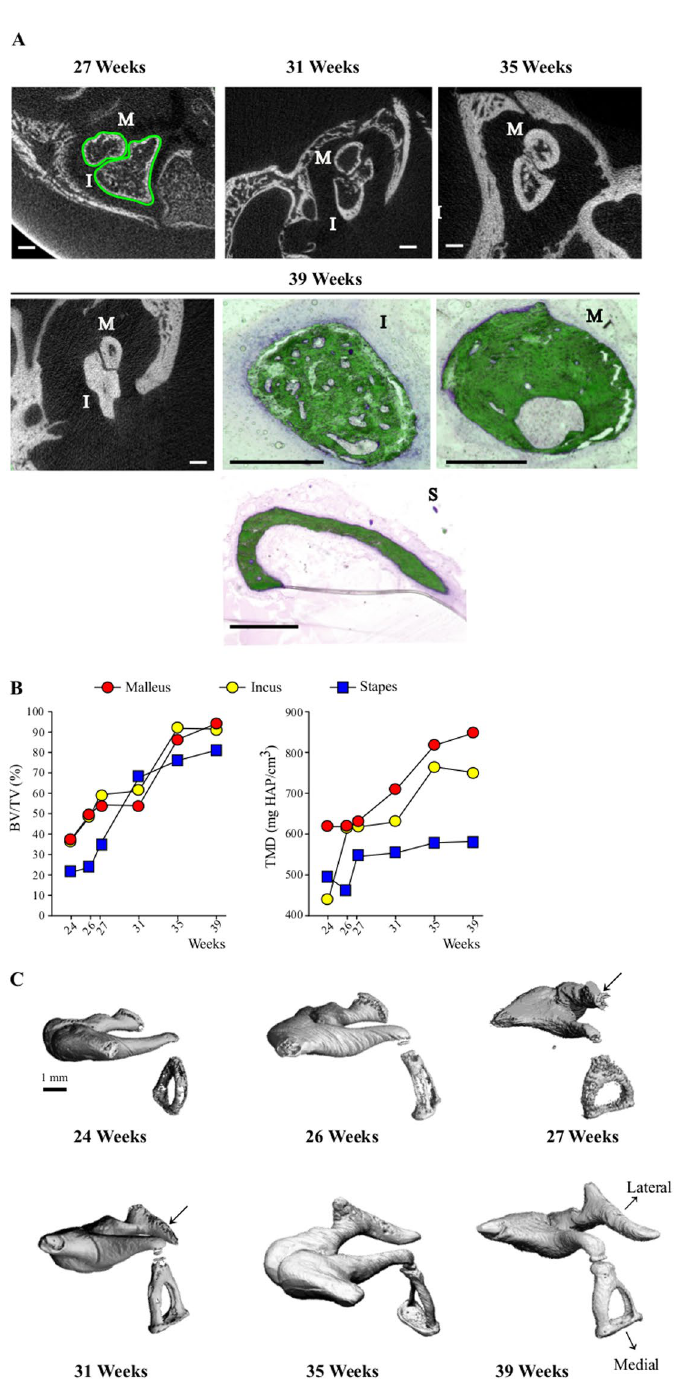
Figure 3. Inner ear development-Ossicle bone maturation. ( A ) 2D μ CT and Goldner stained sections of ossicles at 27, 31, 35 and 39 weeks. M: Malleus, I: Incus, S: Stapes. White bars = 1.0 mm, black bars = 0.5 mm. ROI definition for μ CT analysis and 3D rendering are outlined in green in the upper left image. ( B ) Time- course of bone volume (BV/TV) and tissue mineral density (TMD) increase and ( C ) 3D μ CT rendering of ossicles in successive weeks of gestation: the lateral and medial orientation of the ossicular chain are indicated, thick arrows =